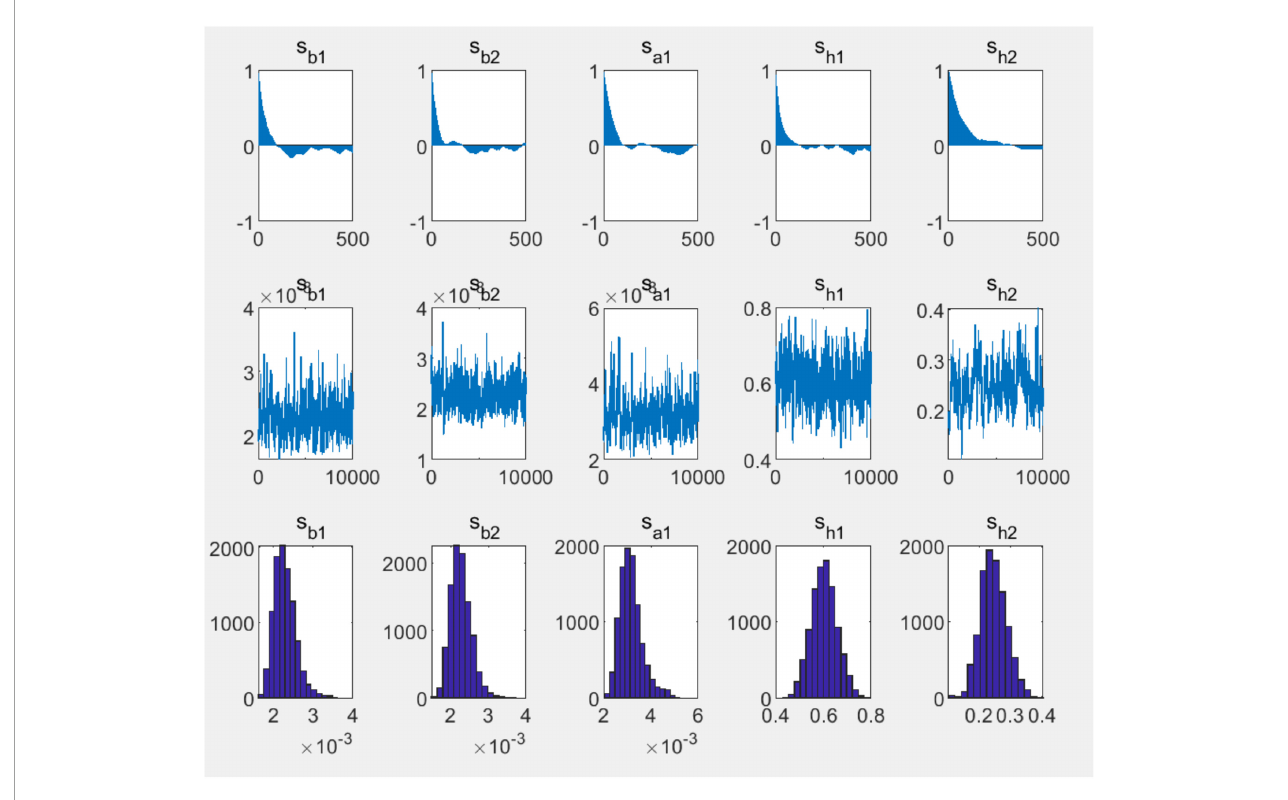
FIGURE3 Parameter estimation results.